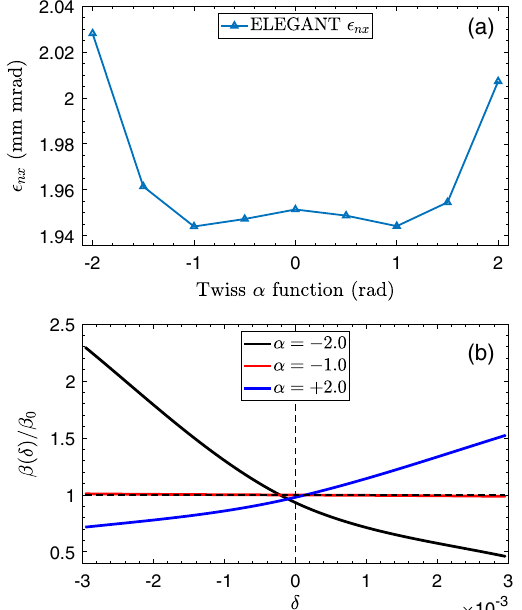
FIG. 7. Normalized emittance from the achromatic dog-leg transfer line (a) and slice Twiss parameters according to the energy distribution (b) obtained using particle tracking. The Twiss initial β function is fixed at 0.1 m.